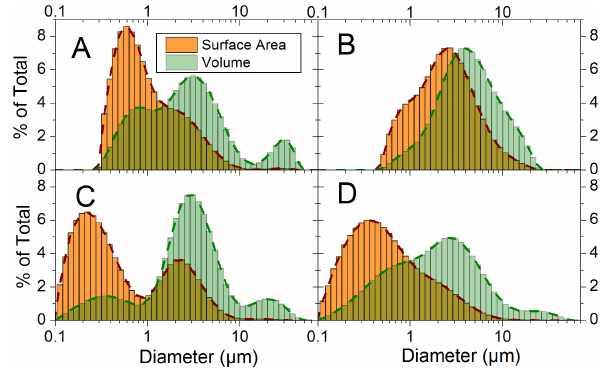
Fig. 2. Particle size distribution histograms determined by laser diffraction for soil dusts A–D examined during this study. Dashed lines following the surface area and volume distributions are pro- vided for